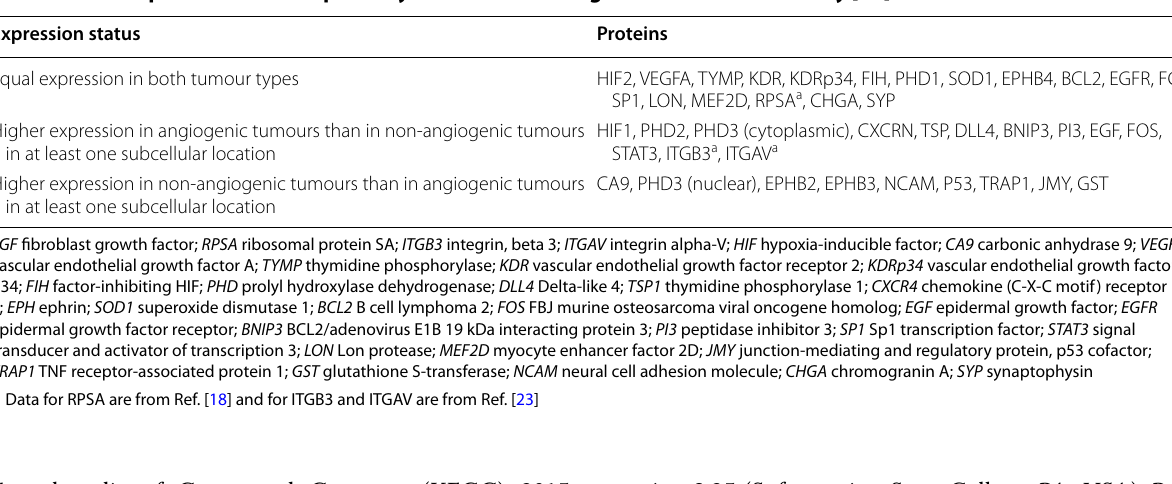
Table 2 Lists of proteins used for pathway visualization using the EnrichrWebd facility [21]